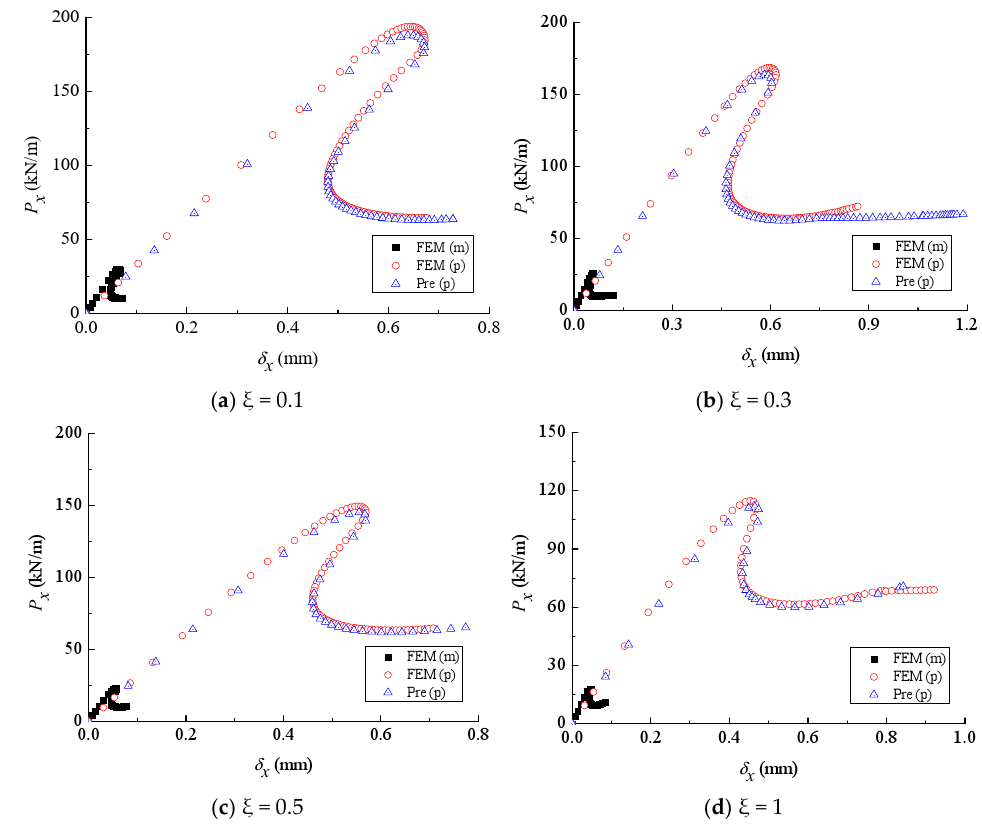
Figure 16. Comparison of the predicted and original load vs. end-shortening curves of the stringer- stiffened cylinders with the SS3 boundary condition when the model material is brass.